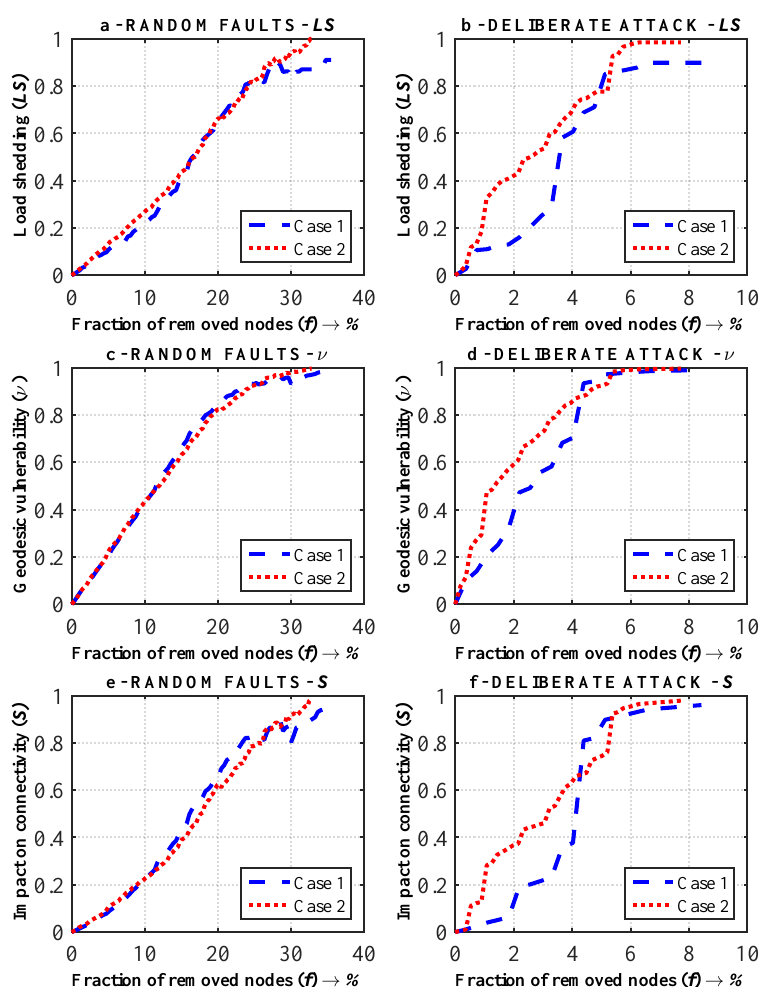
Figure 7. Simulation results for cascading failure